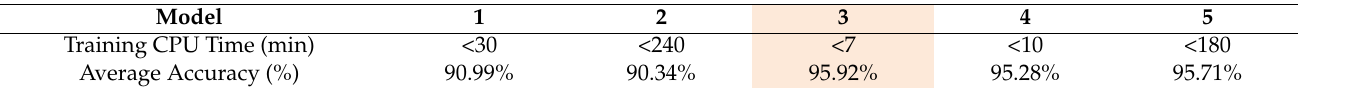
Table 4. Comparisons of average training CPU time and average accuracy (%) for five different CNN